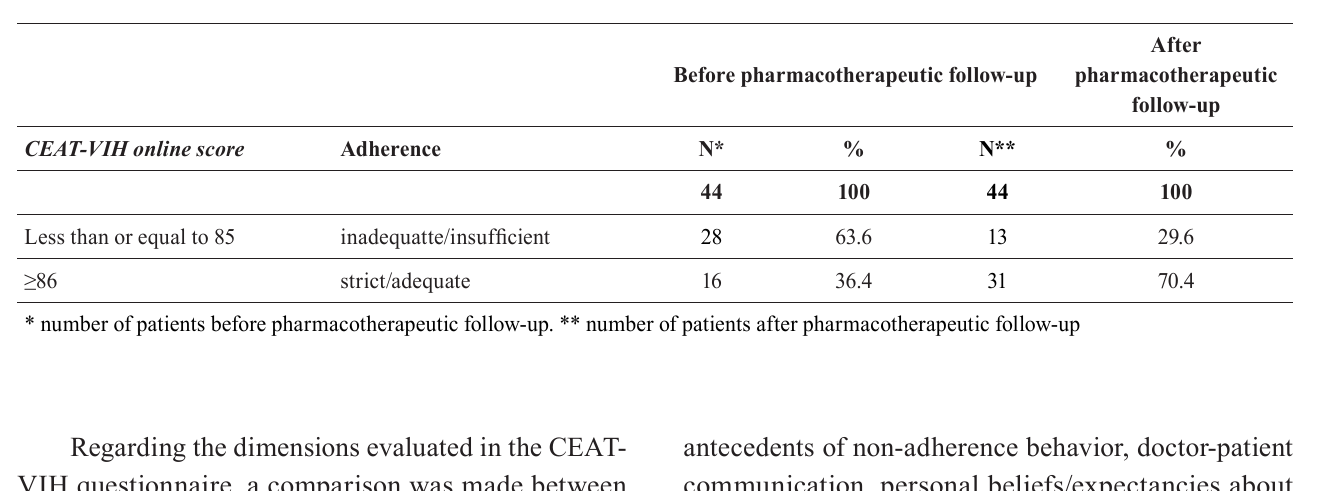
TABLE IV - Adherence to Antiretroviral Therapy according to CEAT-VIH result before and after pharmacotherapeutic follow-up